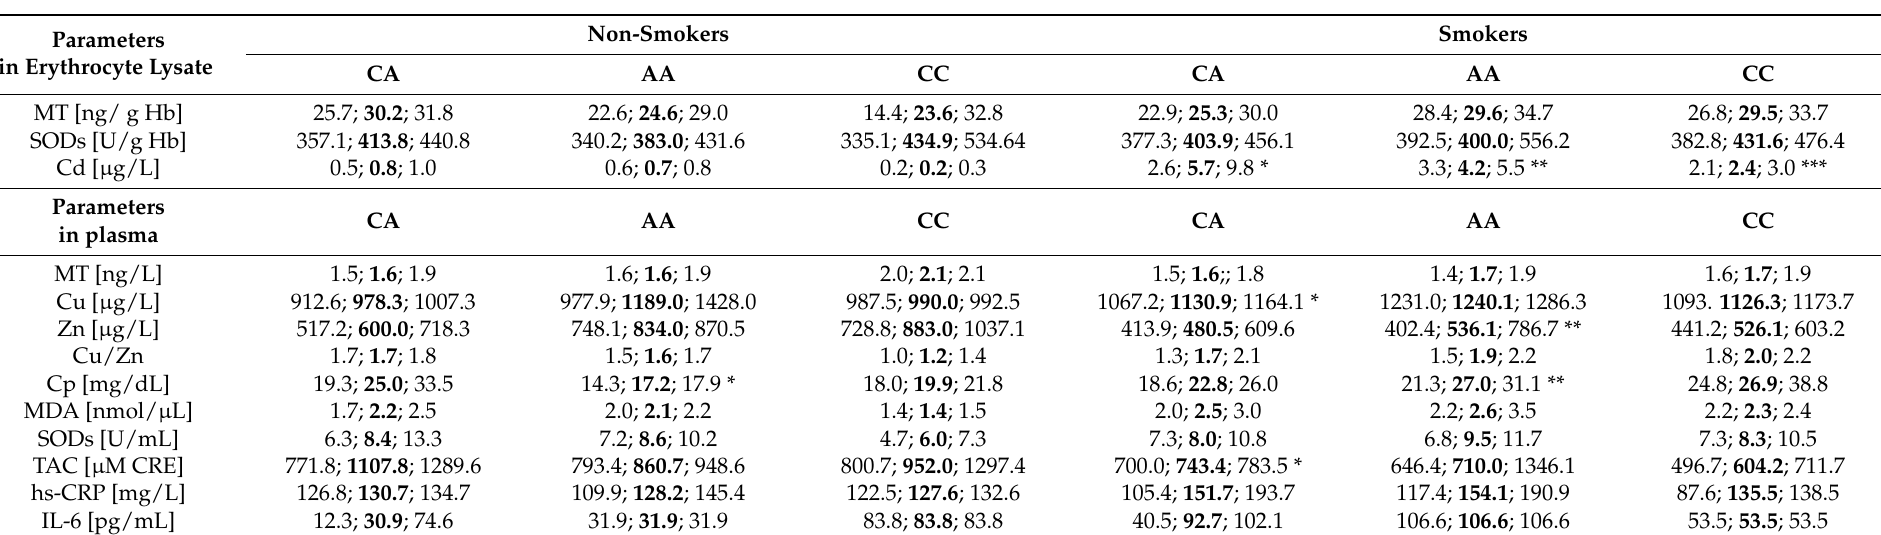
Table 4. The concentration of metals (Cu, Zn and Cd), MT, Cp and markers of inflammation and oxidative stress in groups of non-smoking and smoking patients with AP, with regard to genotypes for rs11640851 in the MT1A gene. The bold is to distinguish the median values.